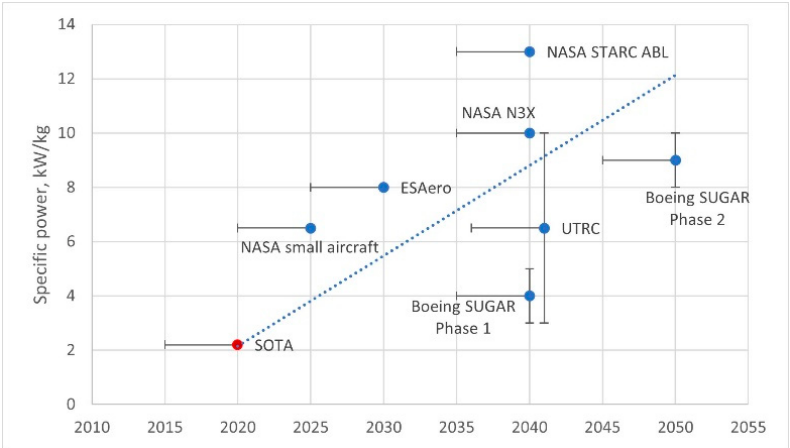
Figure 10. Trend of electric drives specific power. Reproduced from data presented in Ref. [1].